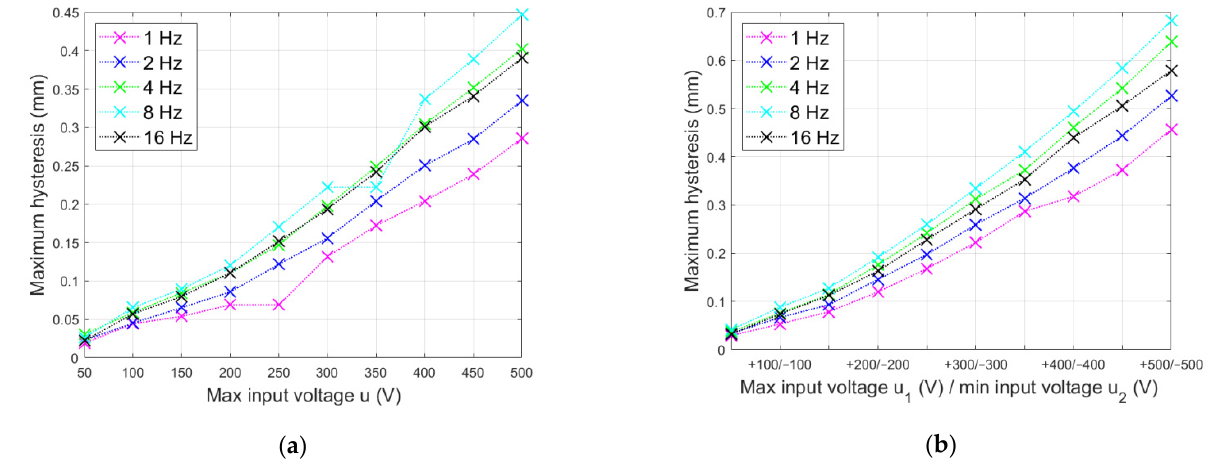
Figure 9. Comparison of the maximum hystereses ( a ) for the unimorph, and ( b ) for the bimorph.